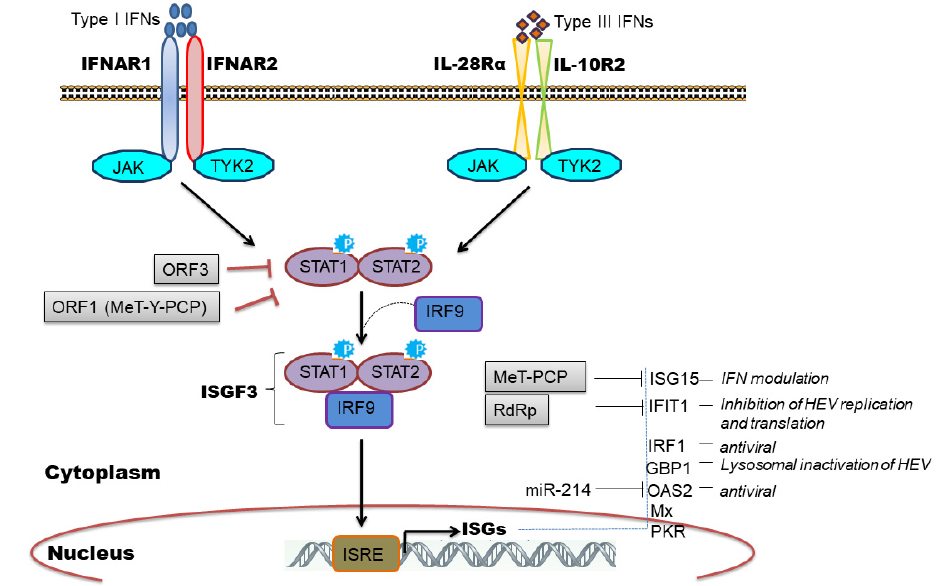
Figure 3. A model depicting induction of Type I and type III IFNS by engaging IFNAR1/IFNAR2 and IL-28R α /IL-10R2 receptors, respectively and strategies evolved by HEV to evade host innate response. Type I and type III IFNs binds to their respective receptors which results in phosphorylation of STAT1 and STAT2. Phosphorylated STAT1 and STAT2 forms complex with IRF9 (ISGF3) which is translocated in nucleus to transcribe ISGs from ISRE promoter element. ISGs have different antiviral mechanisms while HEV employs different strategies to evade IFN